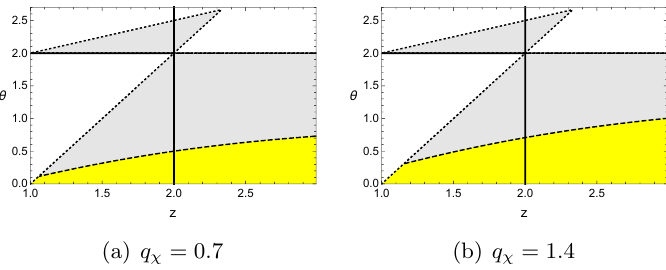
Figure 23 . Sign of the coe(cid:14)cient of q 2 of the (cid:20) xx near q 2 = 0. Yellow region denotes positive 2 sign(WL) and gray region is for negative sign(WAL). Dotted line is NEC. Here we use the same parameters as (cid:12)gure 22 and T = 0 : 04.